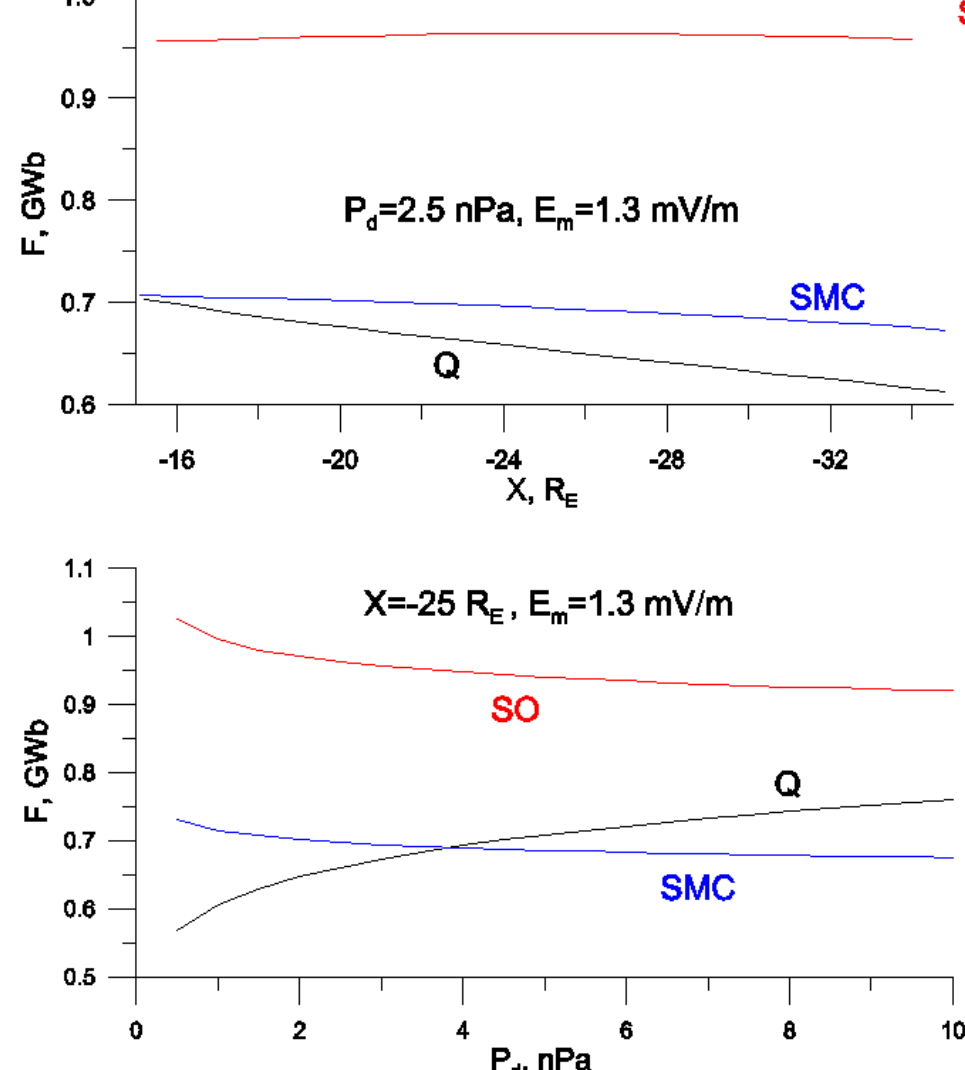
Fig. 5. X -and P d -variations of the model magnetic flux for different magnetospheric